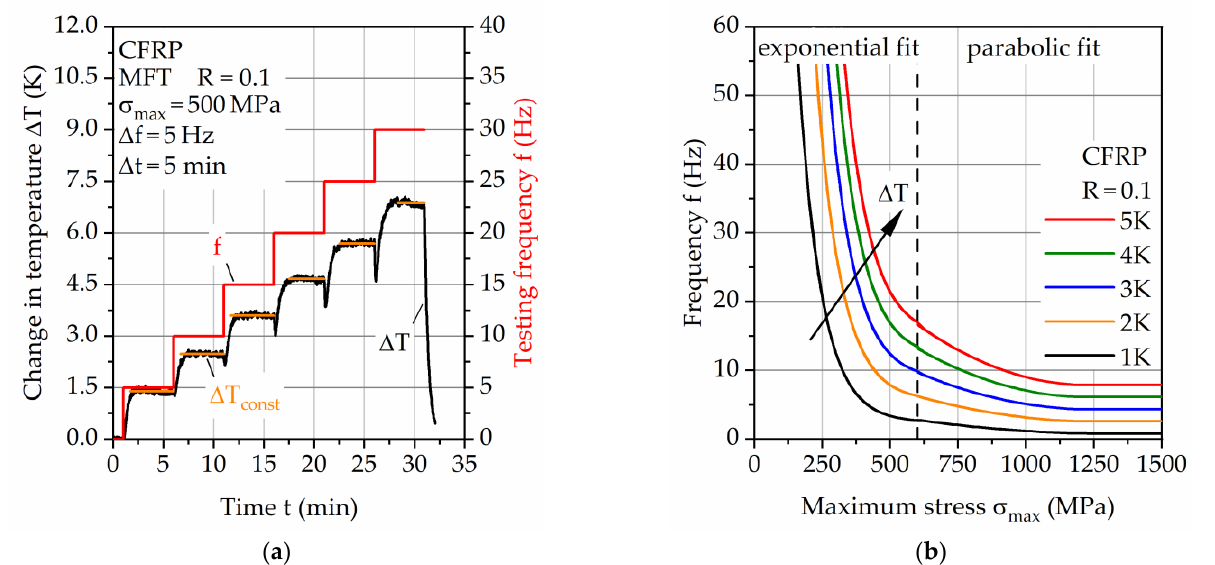
Figure 8. ( a ) Exemplary multiple frequency test on carbon fiber reinforced PA6 and ( b ) derived testing frequency-maximum stress relationship visualized for ΔT from 1 to 5 K.